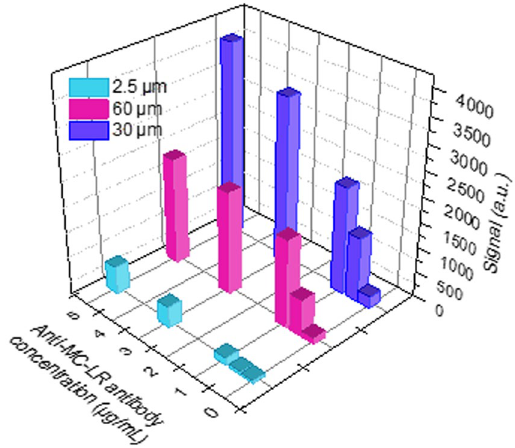
Figure 4. Fluorescence signals from untapered, 30 µ m and 60 µ m tapered waveguides, respectively, towards Cy5.5-labelled anti-MC-LR antibody solution at different concentrations.